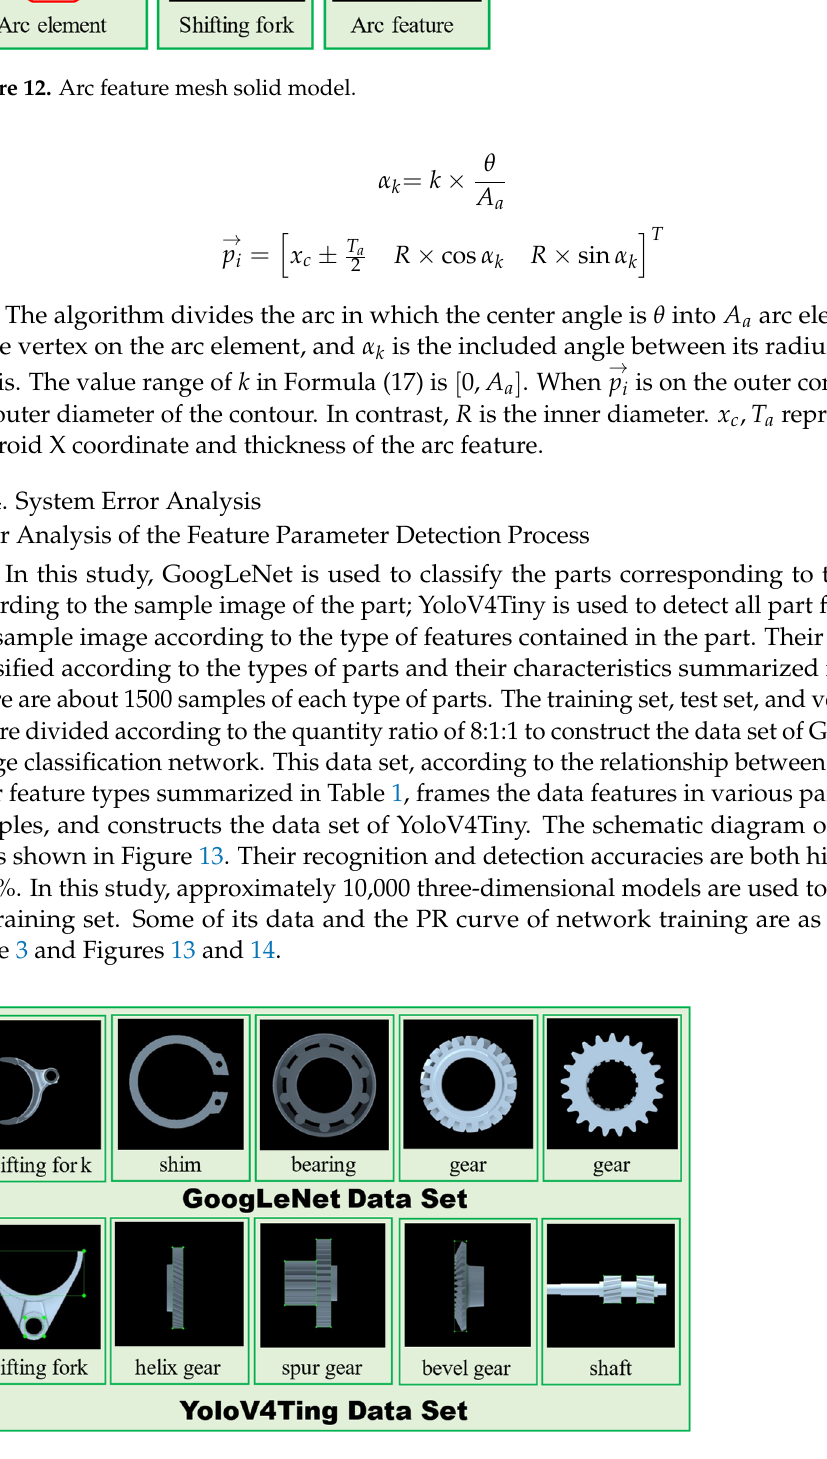
Figure 13. The training dataset of the deep-learning network.